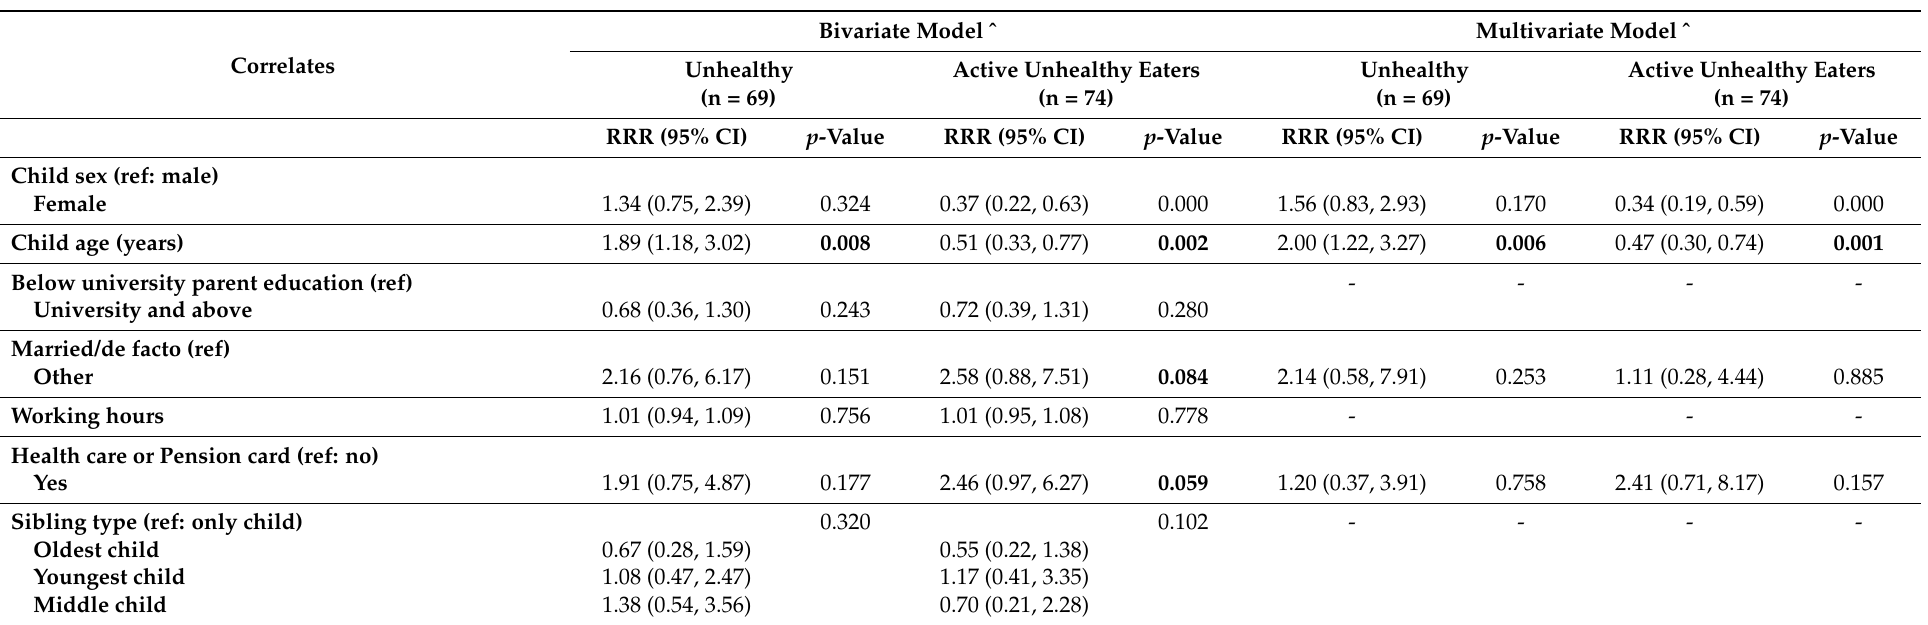
Table 2. Associations of behavioural patterns and child and family level correlates at 6–8 y (n =